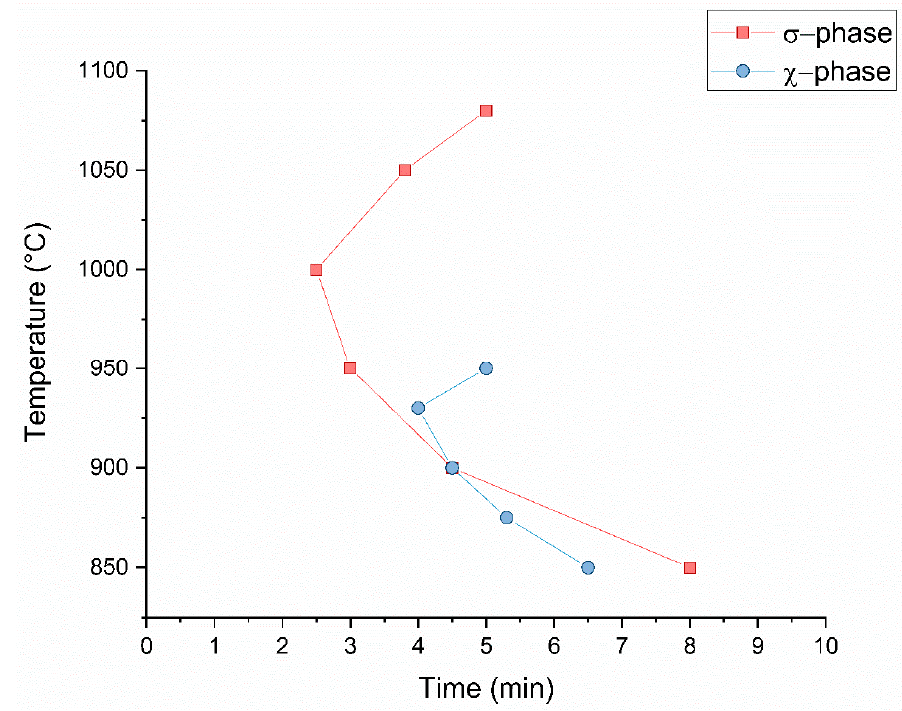
Figure 6. The first observed appearance of σ -phase and χ -phase (approximately 0.1%).